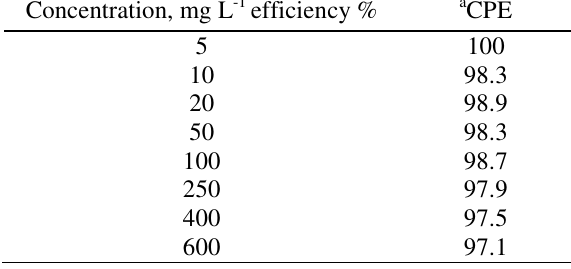
Table 1. Effect of initial dye concentration on the CPE efficiency of reactive black